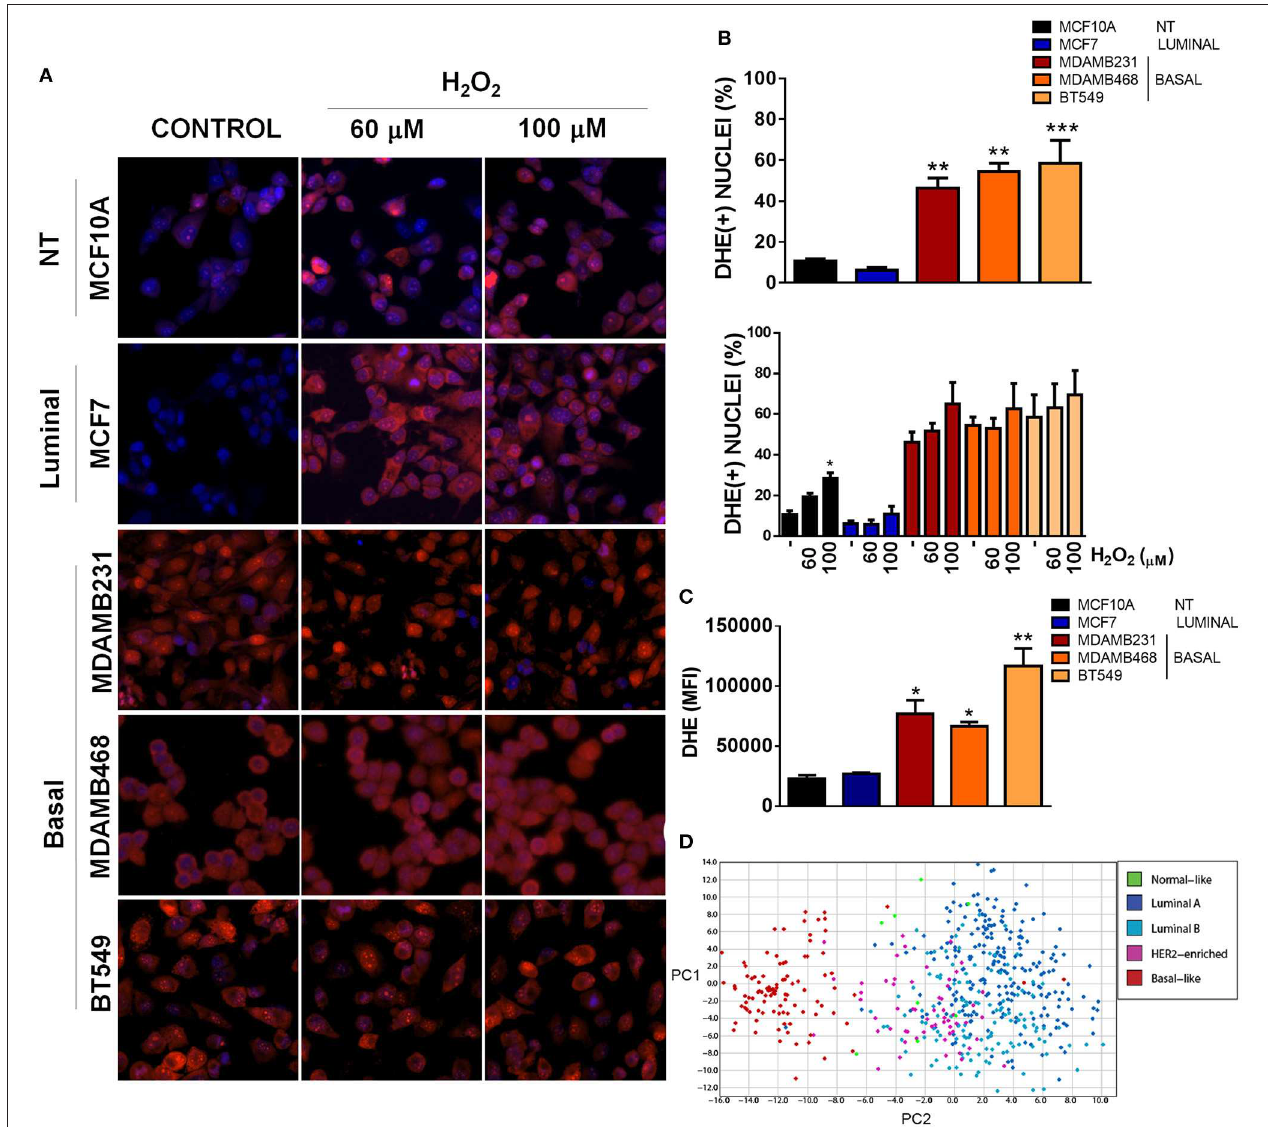
FIGURE 3 | Basal, TNBC cell lines have elevated ROS levels when compared to non-tumorigenic or luminal breast cancer cell lines. (A) ROS levels were evaluated by fluorescence microscopy using dihydroethidium (DHE) staining (red) and total nuclei were stained with Hoechst (blue). Cells were treated with the indicated concentrations of H 2 O 2. (B) DHE positive nuclei were counted and graphed as a percentage of total nuclei. (C) ROS levels were quantitatively evaluated by flow cytometry in the different cell lines. (D) A ROS-related gene signature PCA analysis clearly clustered basal-like tumors separate from the other breast cancer subtypes. Graphs show mean ± SEM of 3–5 independent experiments, *Different to MCF10A and MCF7 or to their respective control with * p < 0.05; ** p < 0.01, and *** p < 0.001. PC, principal